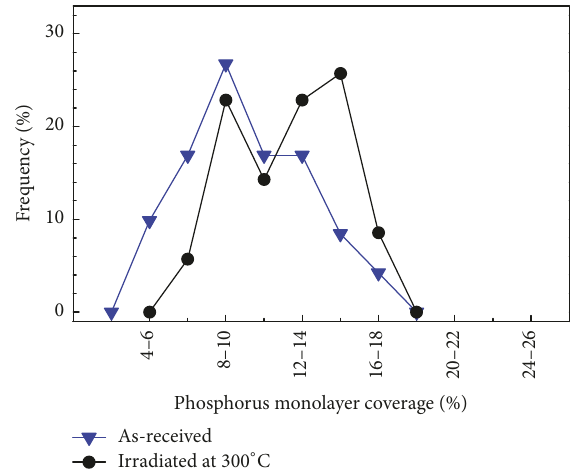
Figure 9: Grain boundary concentration of phosphorus in 15Kh2NMFAA steel specimens: as-received and after irradiation at 300 ∘ b